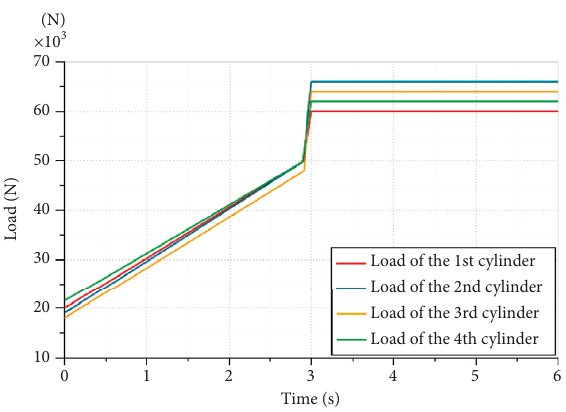
Figure 10: Input curve of signal source load.